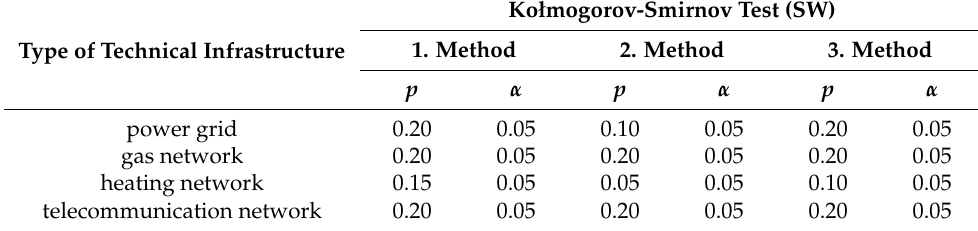
Table 5. Table showing the results of the KS.